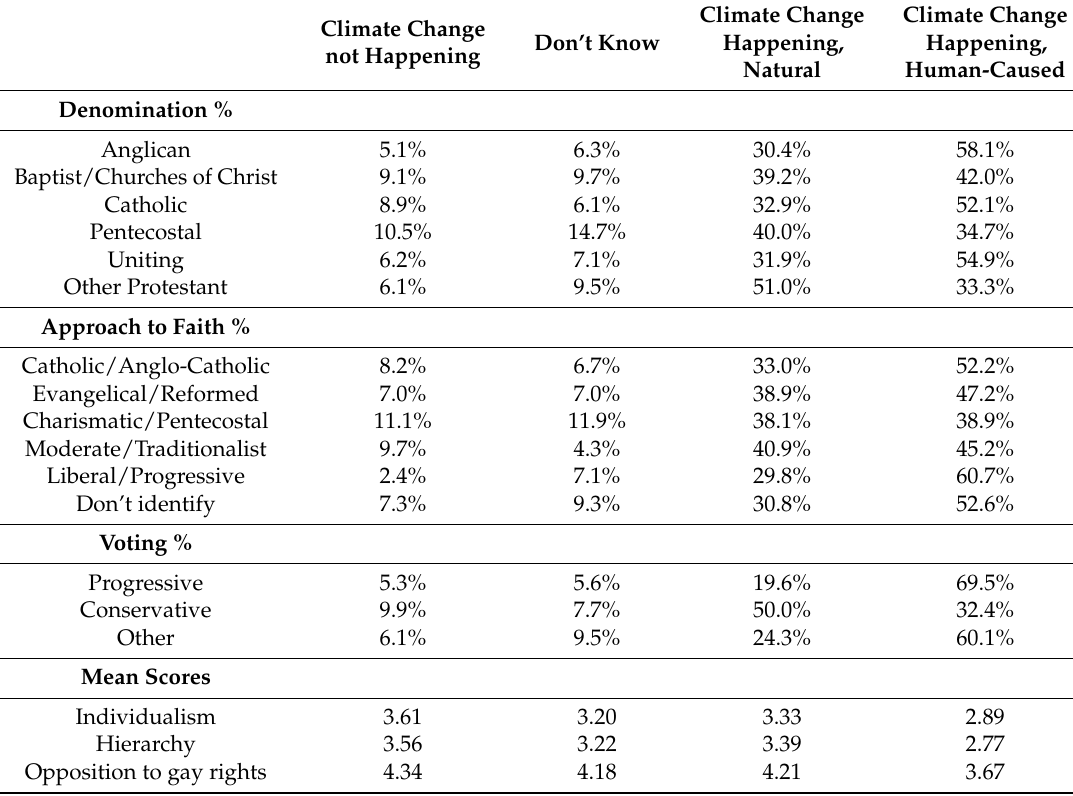
Table 3. Bivariate relationships between climate change beliefs and other study